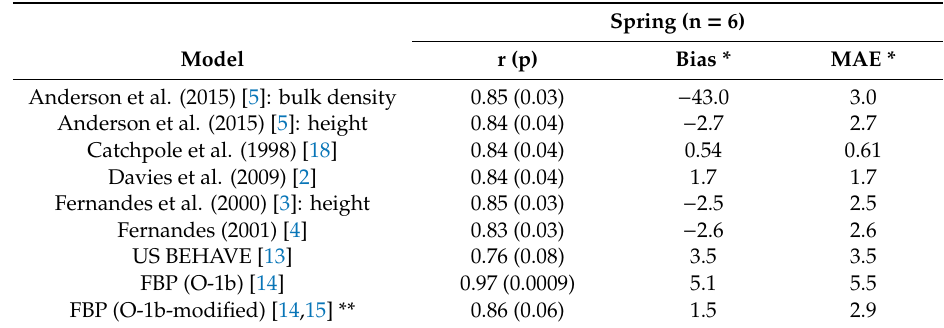
Table A5. Comparison of various shrub fire behaviour models with the outlier point from Unit 12 removed. (This only influences the Springtime